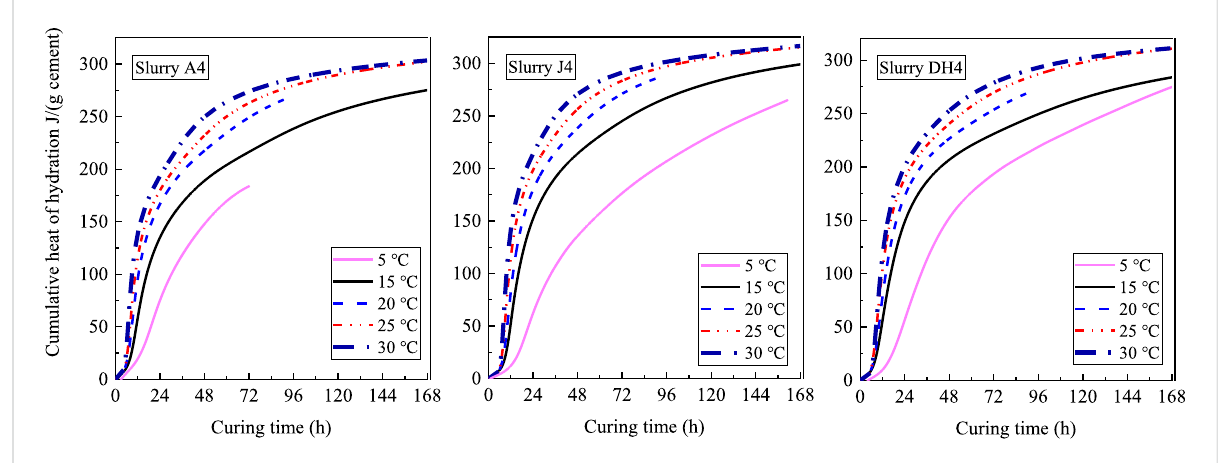
FIGURE 5 In fl uence of low temperatures on cumulative heat evolution of cements from different manufacturers. (w/c=0.4).